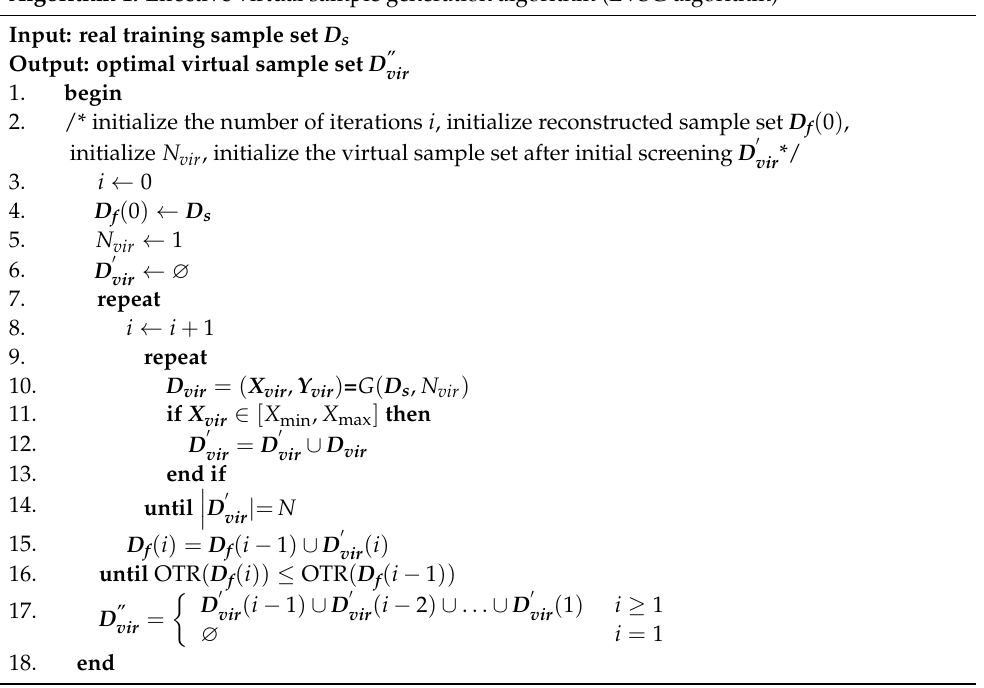
Algorithm 1: Effective virtual sample generation algorithm (EVSG